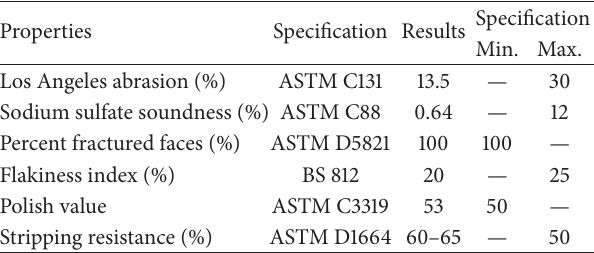
Table 1: The physical properties of coarse aggregate.